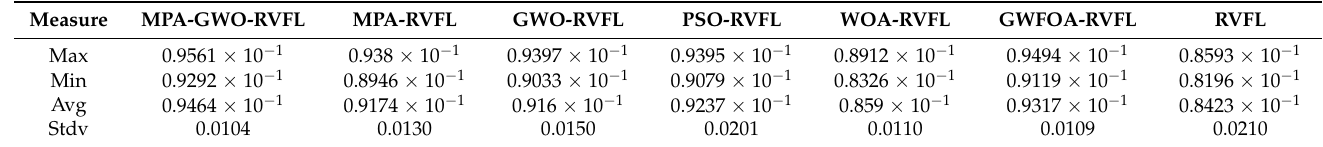
Table 4. Model comparison experimental results.